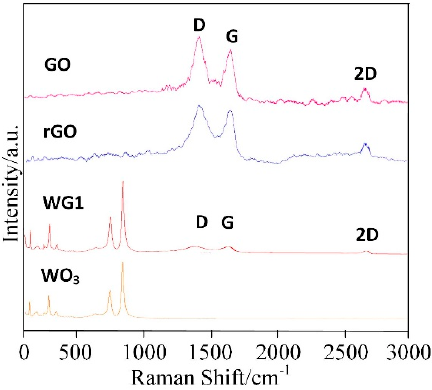
Figure 5. Raman spectra of rGO, GO, WG1, and WO 3 nanocomposites.